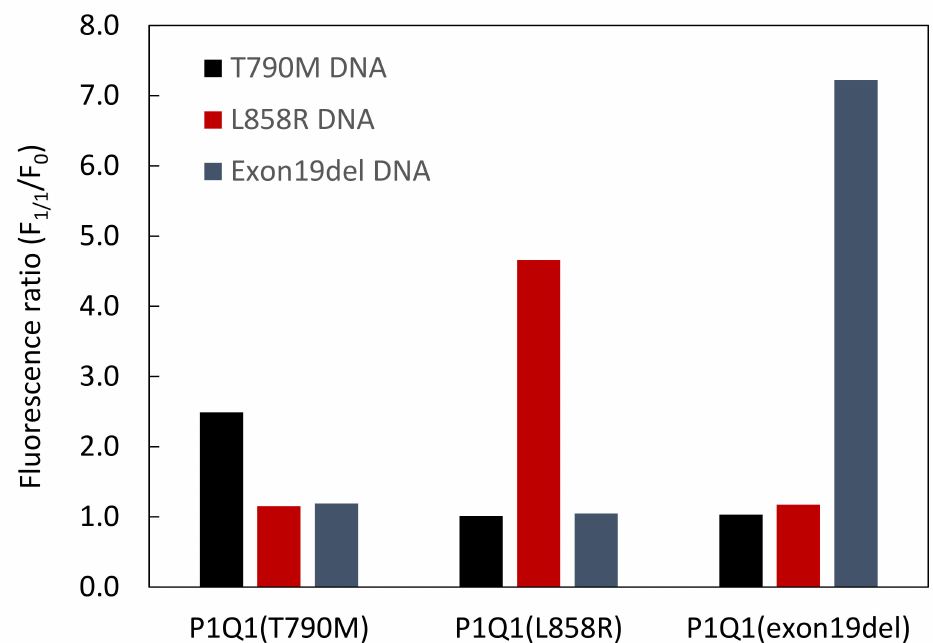
Figure 6. Fluorescence ratios (F 1/1 /F 0 ) of the 1:1 mixtures of P1Q1 s with different PNA sequences and